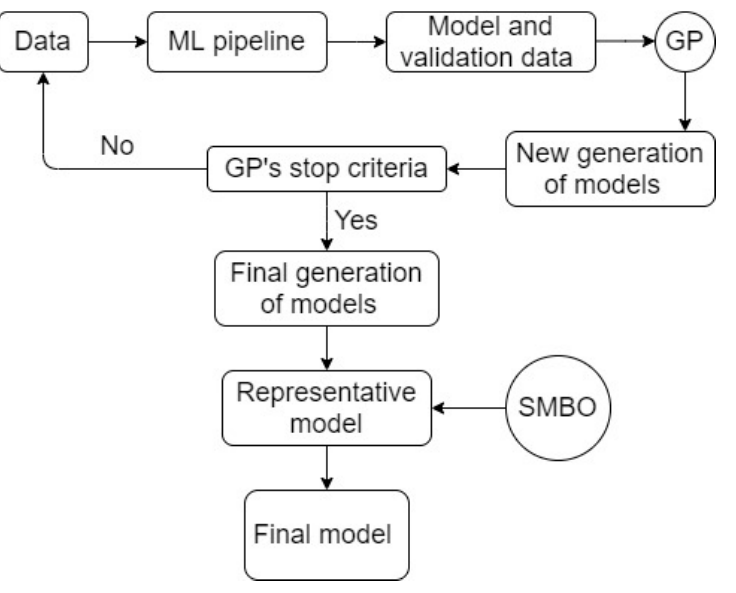
Figure 10. Schematic for workflow 4.